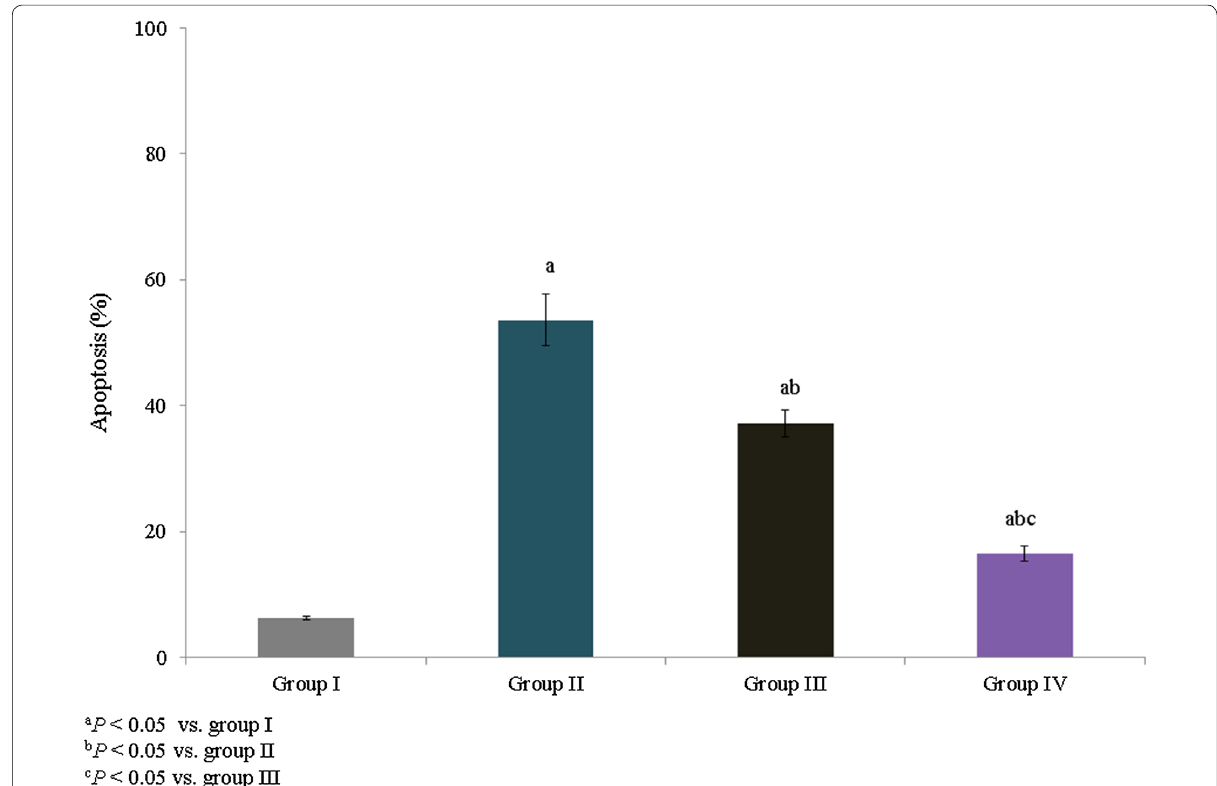
Fig. 4 Effect of E. hirta extract on apoptosis in neonatal asthmatic rats. Experimental data are given as the mean